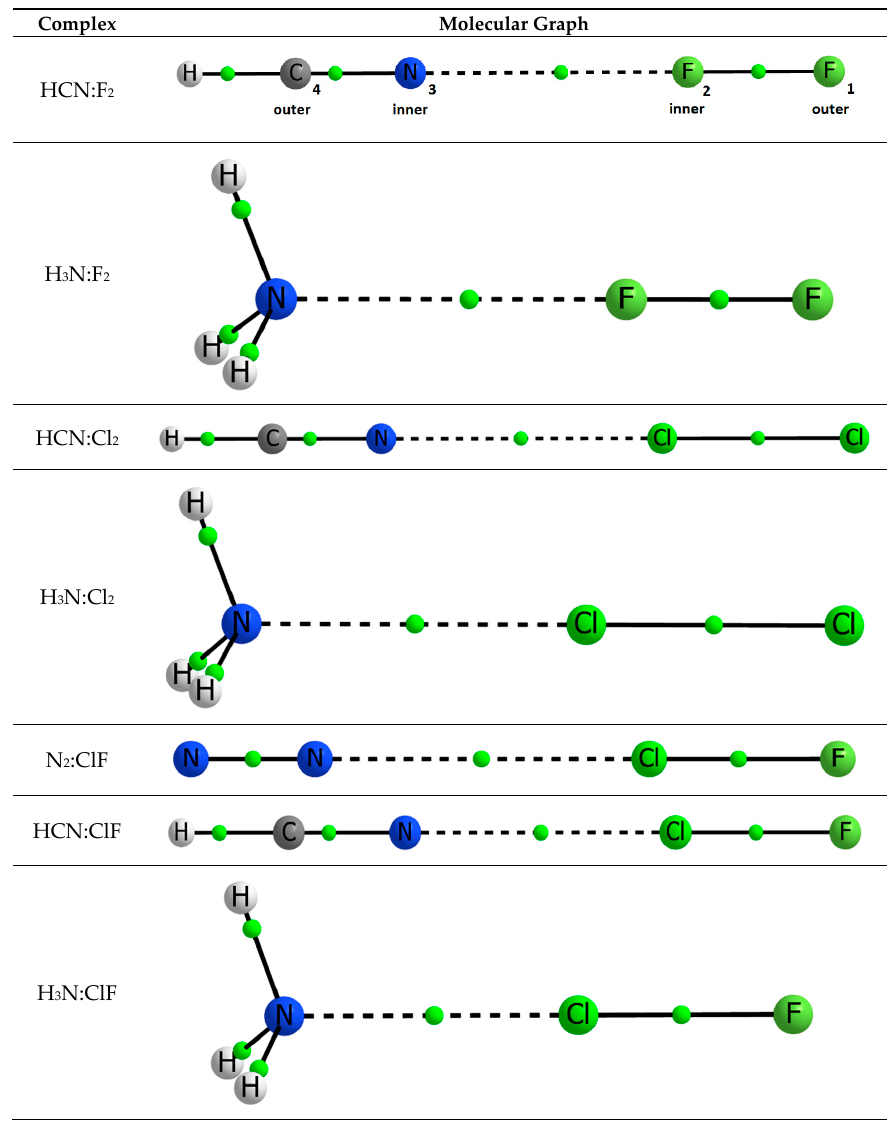
Figure 1. Molecular graphs of all seven complexes studied. The complex HCN:F 2 has been marked to illustrate the labelling throughout the paper. The location of each BCP is marked by a small green sphere. Table 2. Intermolecular BCP properties (all in a.u. except the